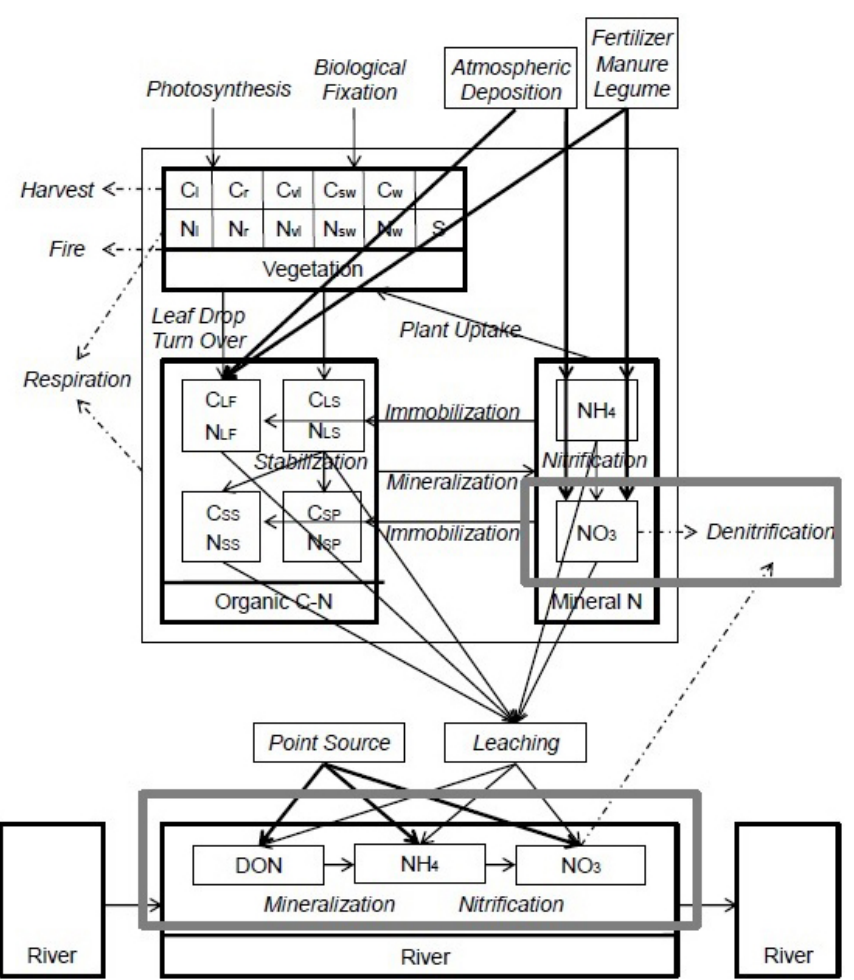
Figure 1. Structure of LM3-TAN. Two thick boxes show the incorporated denitrification module in the terrestrial component and stream microbial processes in the river component. The river systems are a series of continuously stirred tank reactors (CSTR) that simulate stream mineralization, nitrification, and denitrification. The other boxes show major C and N pools in vegetation (leaves, fine roots, labile, sapwood, heartwood, and N buffer storage), soil (fast and slow little, slow and passive soil, mineral N), and river (organic and mineral N). The arrows depict fluxes of anthropogenic N sources (thick solid), C-N organic compounds and mineral N (thin solid) with associated processes (italic), and C and N lost to the atmosphere or anthropogenic pool